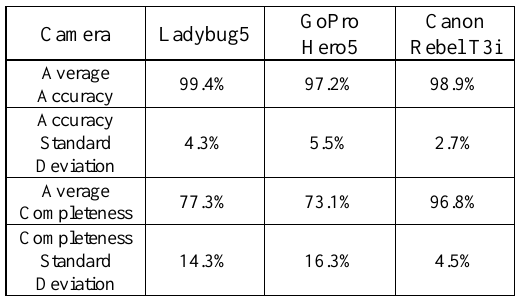
Table 2. Average accuracy and completeness of labelling for all 3 experiments.